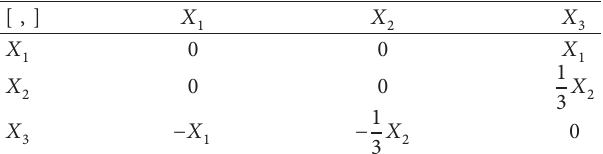
Table 1: The commutator table. Table 2: Adjoint representation of the infinitesimal